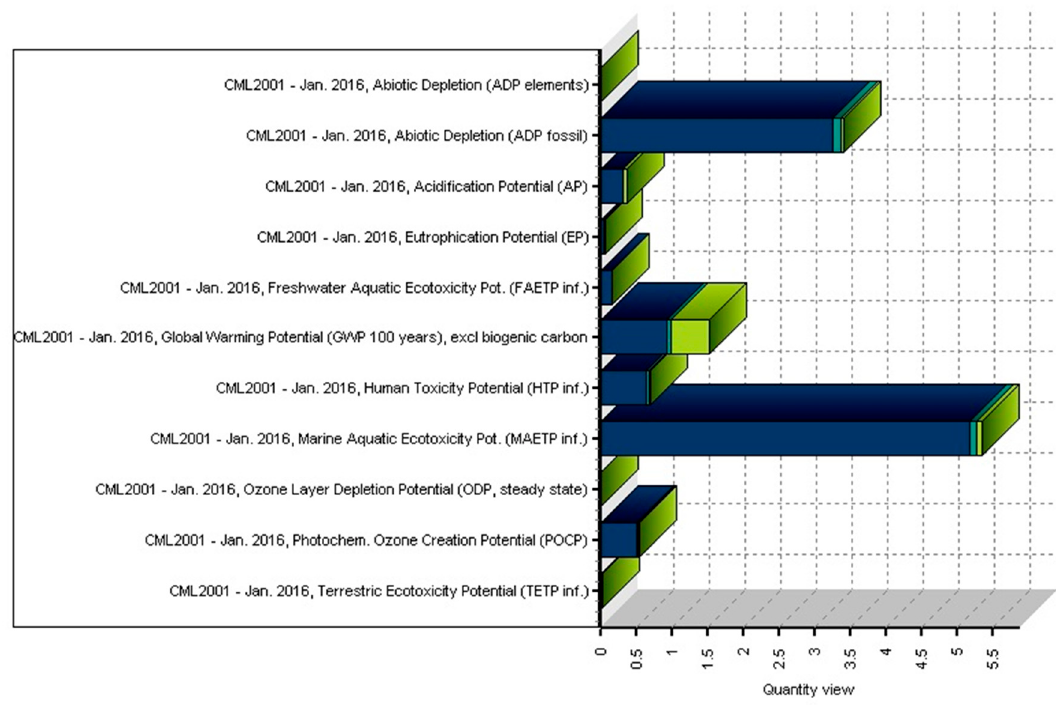
Figure9. Quantityviewforallexaminedimpactcategoriesunderactualoperatingconditions(functional unit: 25 kg polypropylene product. Colours: Dark blue—production phase, light blue—use phase, green—EoL